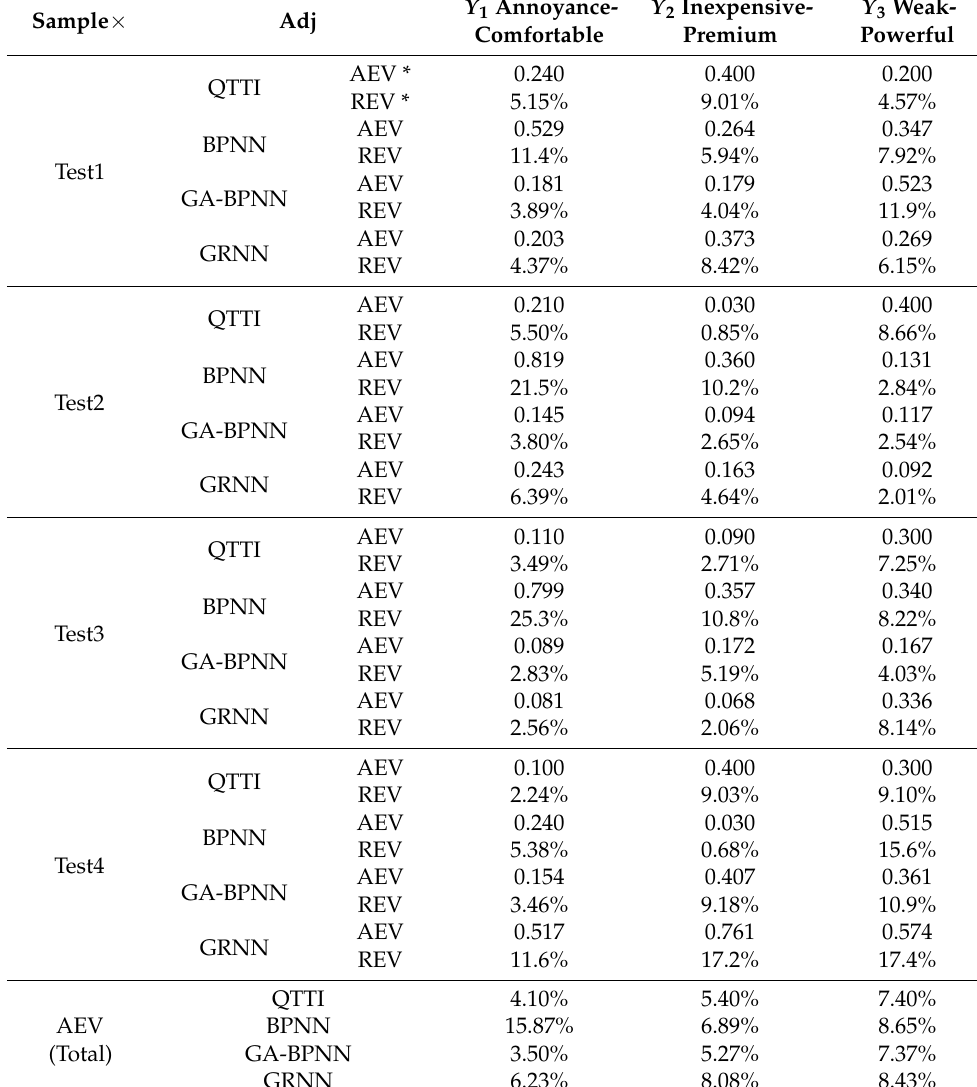
Table 6. Comparative analysis of prediction results of linear and non-linear prediction models. Sample × Adj